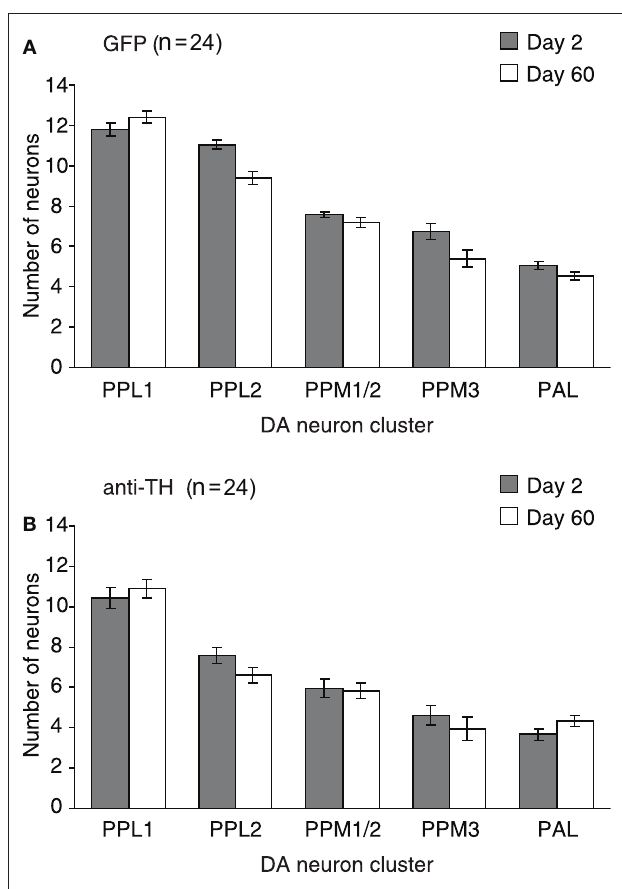
Figure 5 | Dopaminergic neurons do not degenerate in the aging brain of Drosophila . Mean number of DA neurons per hemisphere for the protocerebral cell clusters PPL1, PPL2, PPM1/2, PPM3, and PAL. For each, day 2 and day 60, n = 24 hemispheres were examined to count the DA neuron numbers/cluster of heterozygous female TH > mCD8 :: GFP brains. Neuron numbers are given for day 2 and day 60, quantification was based on